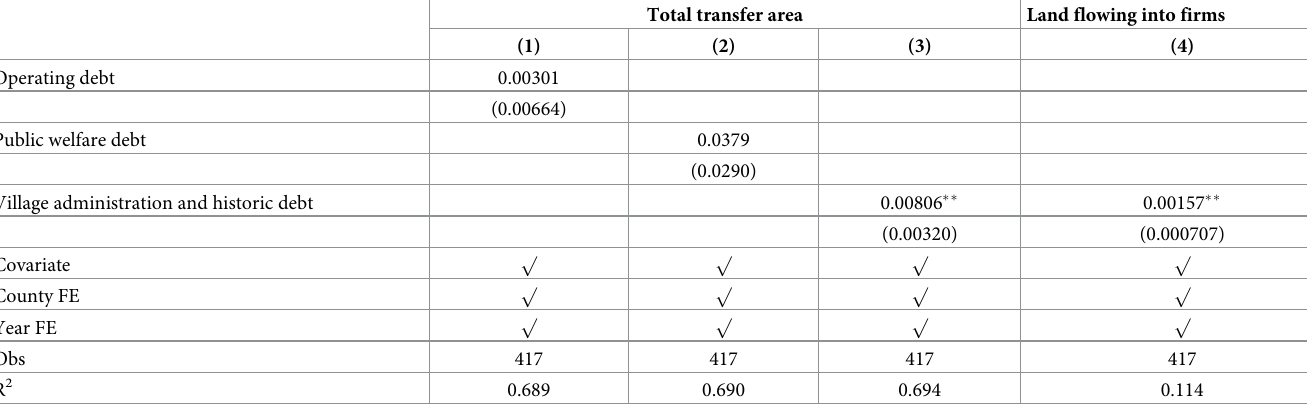
Table 5. The estimation results of the relationship between various village debt and total land